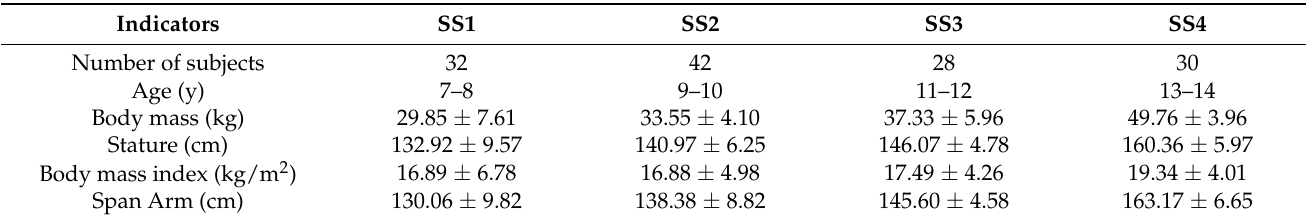
Table 3. Anthropometric data (X ± SD) for the subject in the